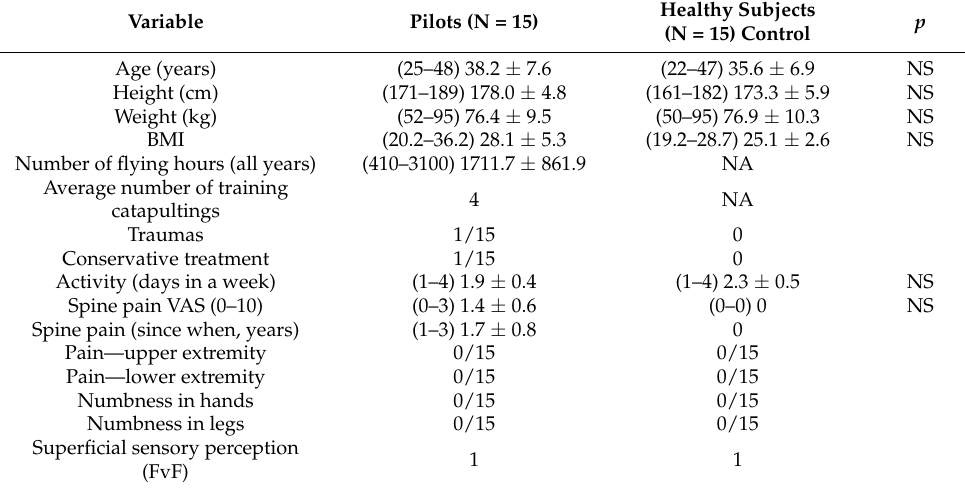
Table 1. Demographic and anthropometric properties, results of reports and clinical studies in pilots and healthy subjects. Ranges, median or mean values with standard deviations are presented.